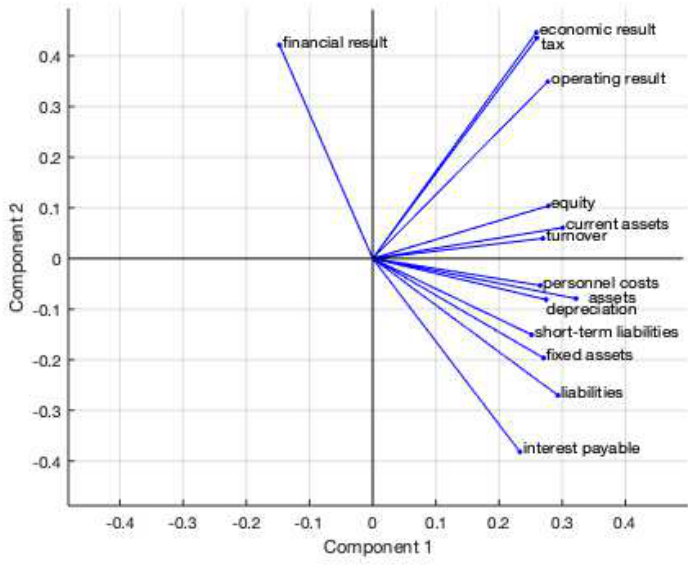
Figure 5. Individual parts involved in a component